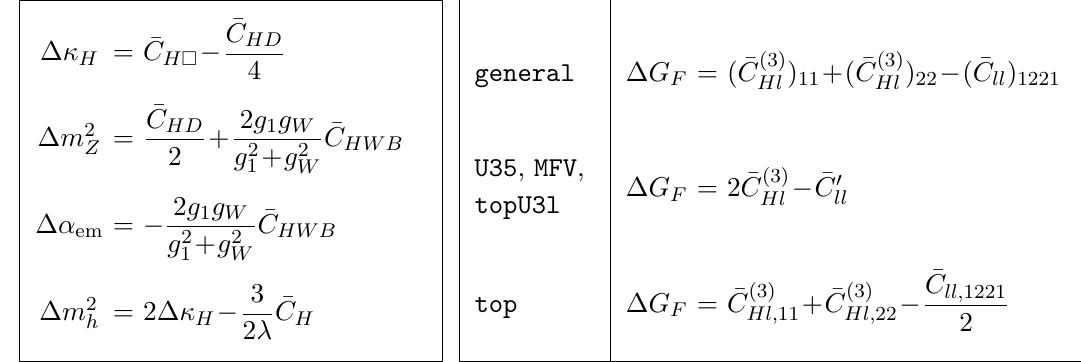
Table 4 . Expressions of input parameter shifts and the kinetic correction ∆ κ H (defined in (2.6)) in terms of Wilson coefficients. The left column is common to all flavor versions, while ∆ G as indicated in the right column. We use the notation ¯ C defined as the bosons’ pole masses, see ref. [1] and references therein for further